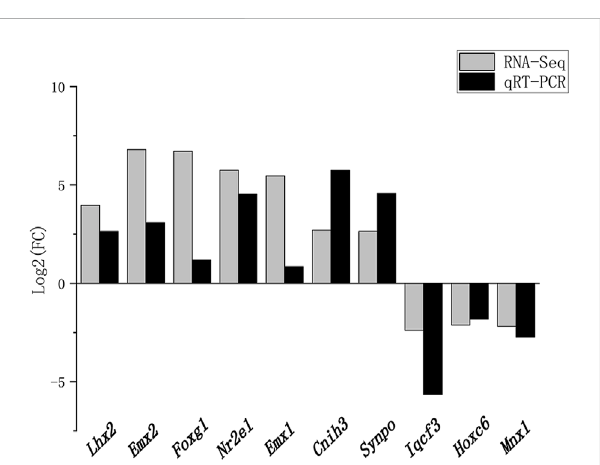
FIGURE 5 ValidationofRNA-seqdatausingRT-qPCR.Foldchangesingene expression between the experimental and control groups detected by RNA-seq were compared with those measured by qRT-PCR. The mRNA levels were normalized to GADPH expression, and the expression fold changes (compared to the control sample) were calculated by using the 2 – ΔΔ Ct method. The x- and y -axes correspond to the genes and log2 (ratio of H/L) measured by RNA-seq and